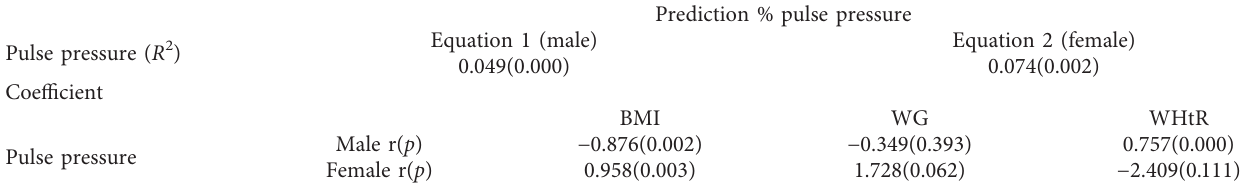
Table 5: Regression analysis summary for anthropometric parameters and pulse pressure in male and female rural dwellers of Afikpo community, Ebonyi State,